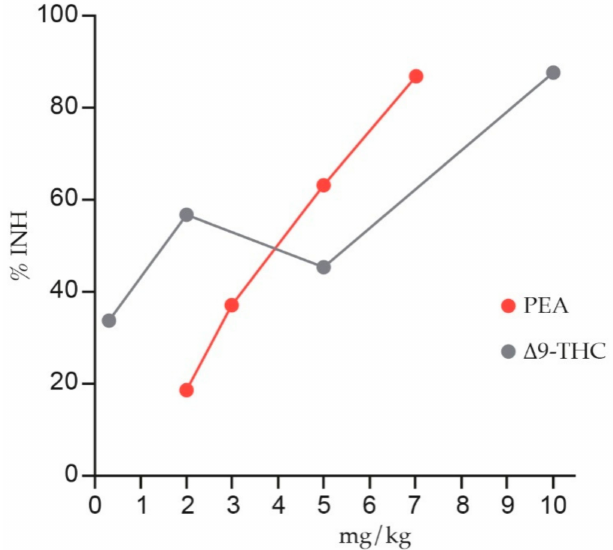
Figure 5. Anti-nociception elicited by ∆ 9-THC and PEA after intraperitoneal administration in a visceral pain model (phenyl-p-quinone, PPQ). The dose response curves for percentage inhibition of stretching movements (%INH) are reported. ∆ 9-THC and PEA were administered 15 min and 10 min prior to PPQ, respectively. Redrawn from [190].